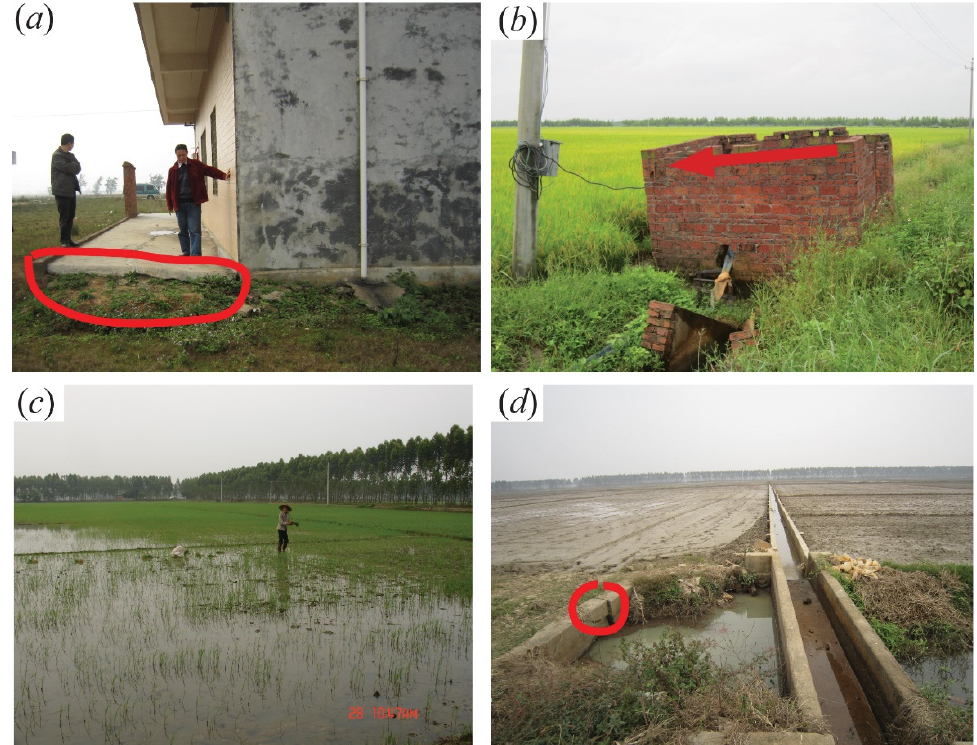
Figure 11. Field photos of non ‐ uniform subsidence of a building ( a ) and a pump facility ( b ), cracking and settlement of a channel ( d ) caused by over ‐ exploiting groundwater in Fucheng town. ( c ) Flooded crops caused by rapid subsidence.